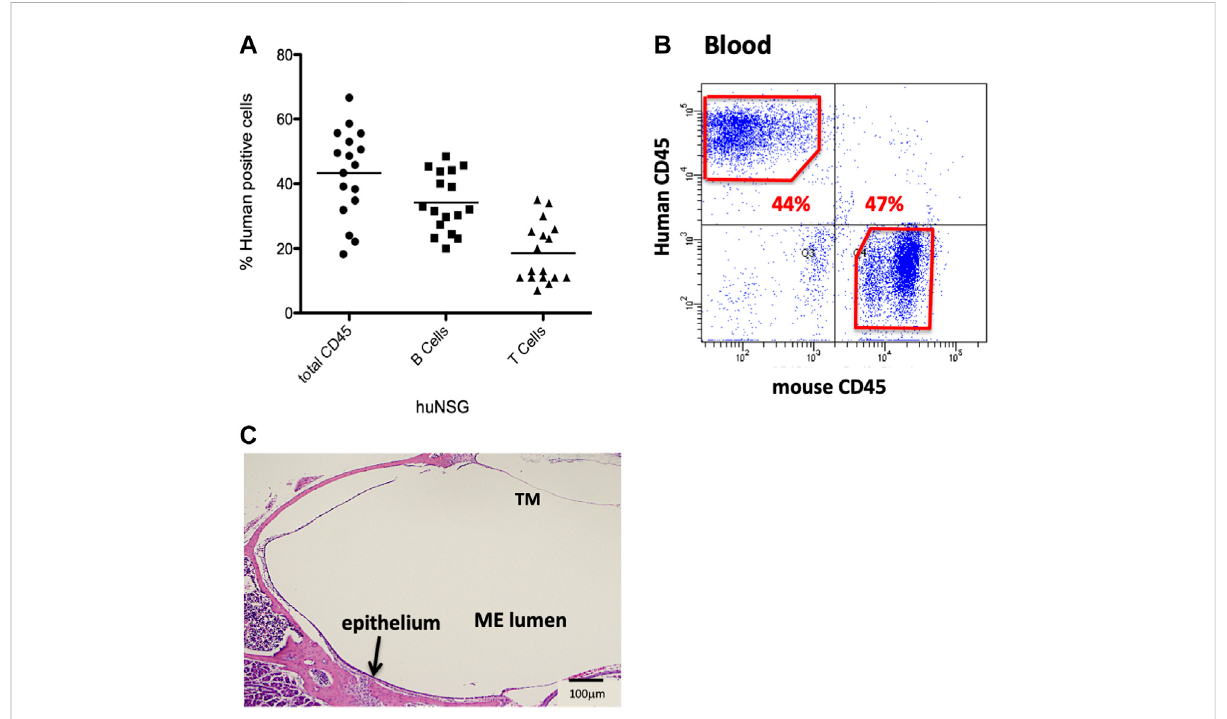
FIGURE 1 Characterization of the NSG mice reconstituted with human CD34 + HSPCs. (A) Average % human CD45 + cells present 12 weeks post- engraftment. (B) Sample fl ow cytometry analysis of hCD45 + vs. mCD45 + cells present in blood of huNSG mice. (C) Histopathology of the middle ear (ME) and inner ear of huNSG mice prior to any experimental challenge showing the mucosa of the normal